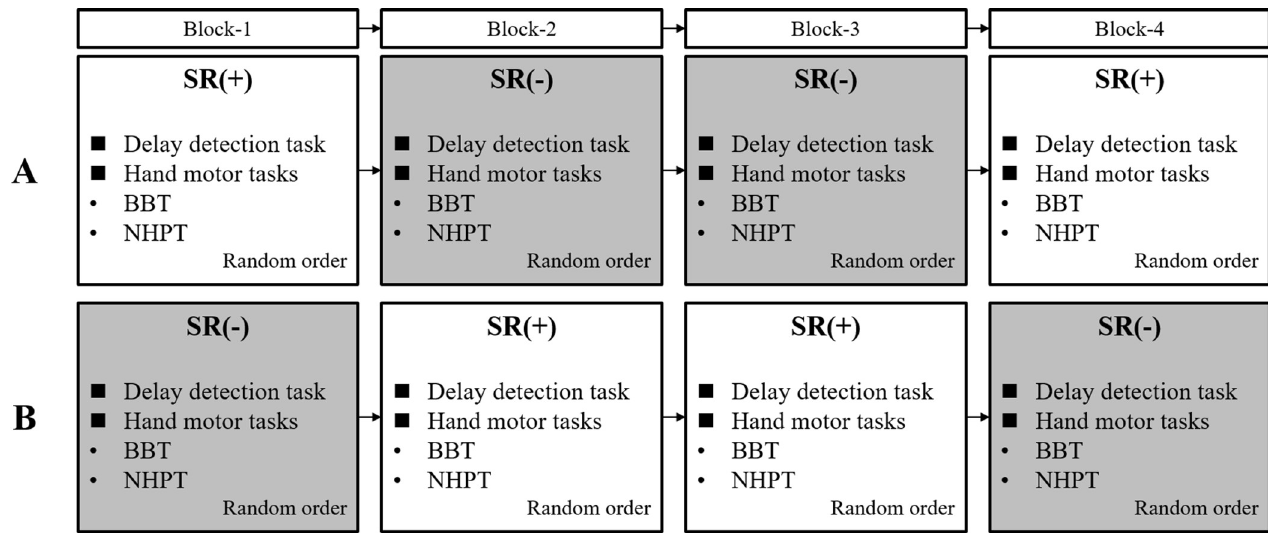
Fig 1. Block design of the experimental protocol. White squares, stochastic resonance (SR) on-condition (+); gray squares, SR off-condition (-); delay detection task, delayed visual feedback detection task; hand motor tasks, hand motor tasks under delayed visual feedback; BBT, box and block test; NHPT, nine hole peg test. (A) Group A: The 15 participants conducted the task in the order of SR on-condition, off-condition, off-condition, and on-condition. (B) Group B: The other 15 participants conducted the task in the order of SR off-condition, on-condition, on-condition, and off-condition. Prior to the start of the four block procedures, the participants received sensory threshold measurements regardless of the SR